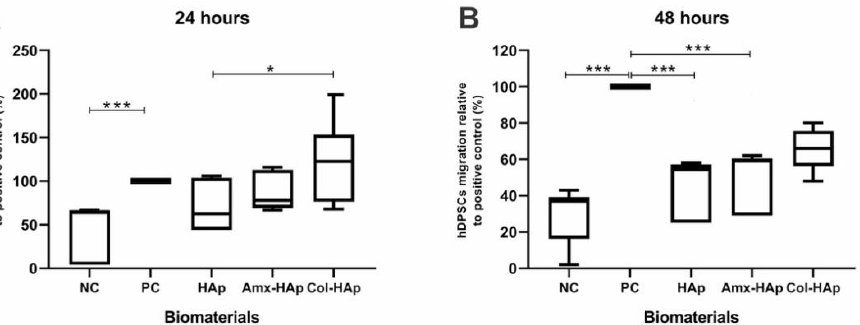
Figure 7. Migration assay of hDPSCs through 8 mm pore membranes toward the tested biomaterials. NC, negative control (IMDM with 1% FBS); PC, positive control (IMDM with 20% FBS); HAps, hydroxyapatite microspheres; Amx–HAp, amoxicillin–hydroxyapatite composite; Col–HAp, collagen–hydroxyapatite composite. The positive control was normalized for the 100% migration rate. Statistical analysis was performed using the Kruskal–Wallis test with the Dunn post-test; p -values: * p < 0.05 and *** p < 0.001. A) Migration assay after 24 hours. B) Migration assay after 48 hours.